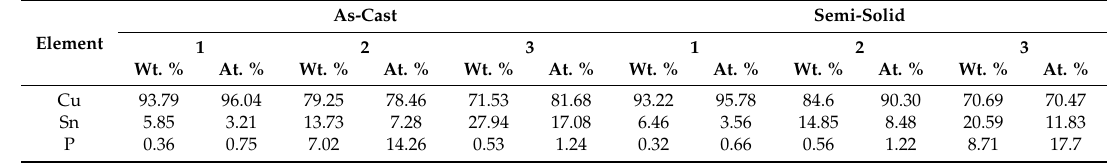
Table 2. EDS results for the microstructure of the as-cast and semi-solid ZCuSn10P1 alloy.